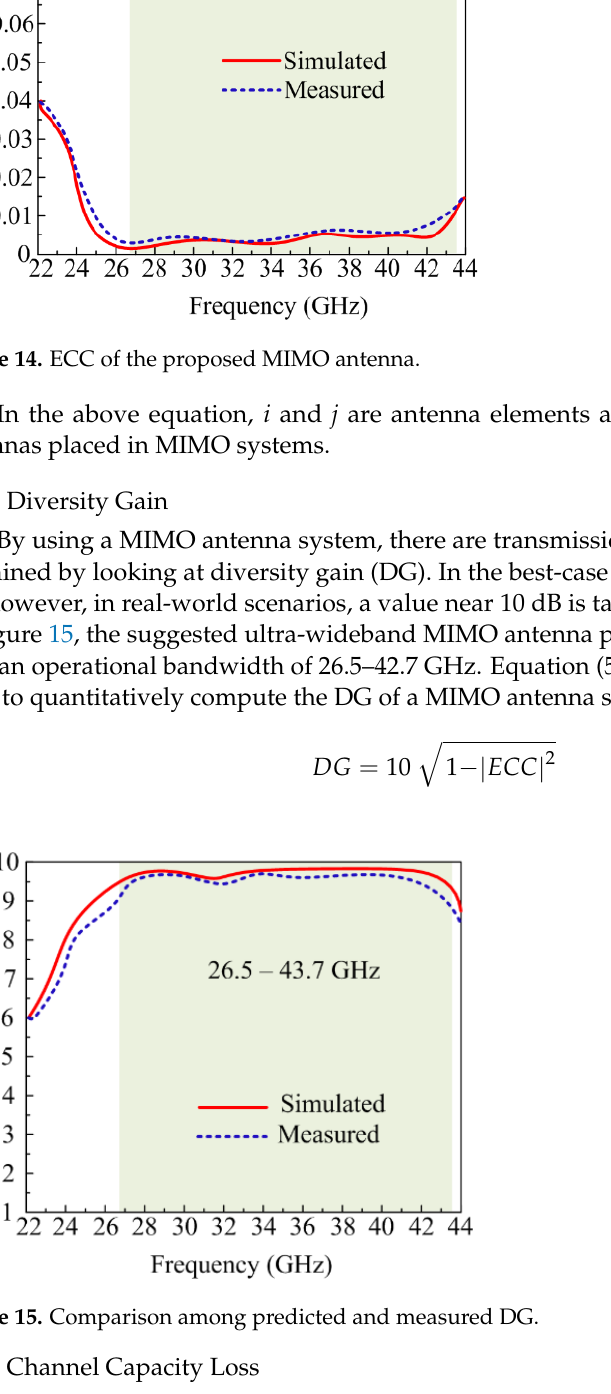
Figure 15. Comparison among predicted and measured DG.